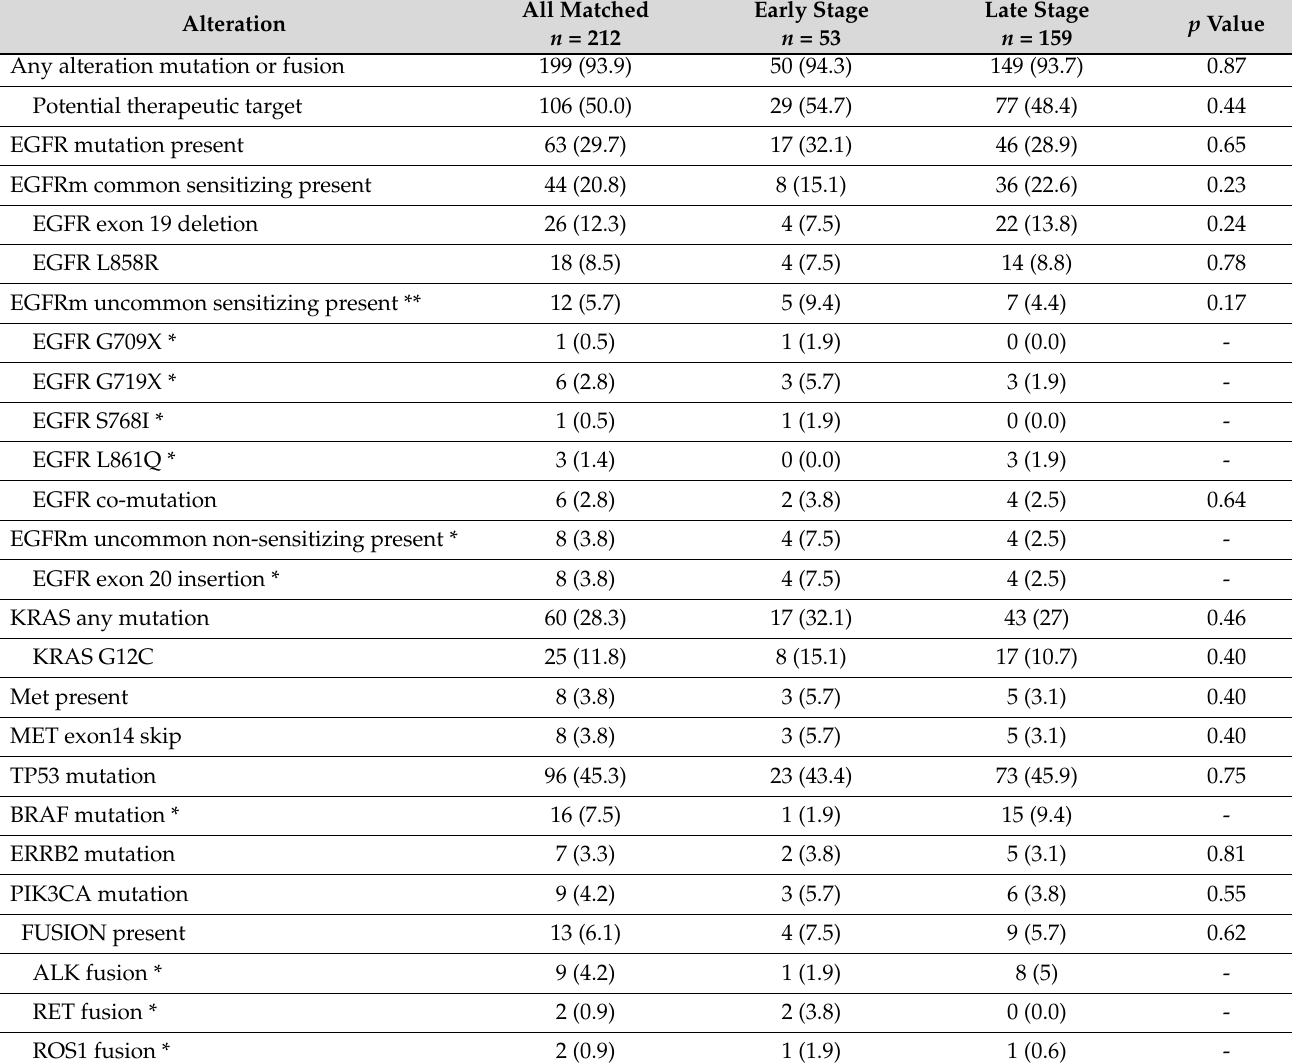
Table 4. Summary of outcomes among matched